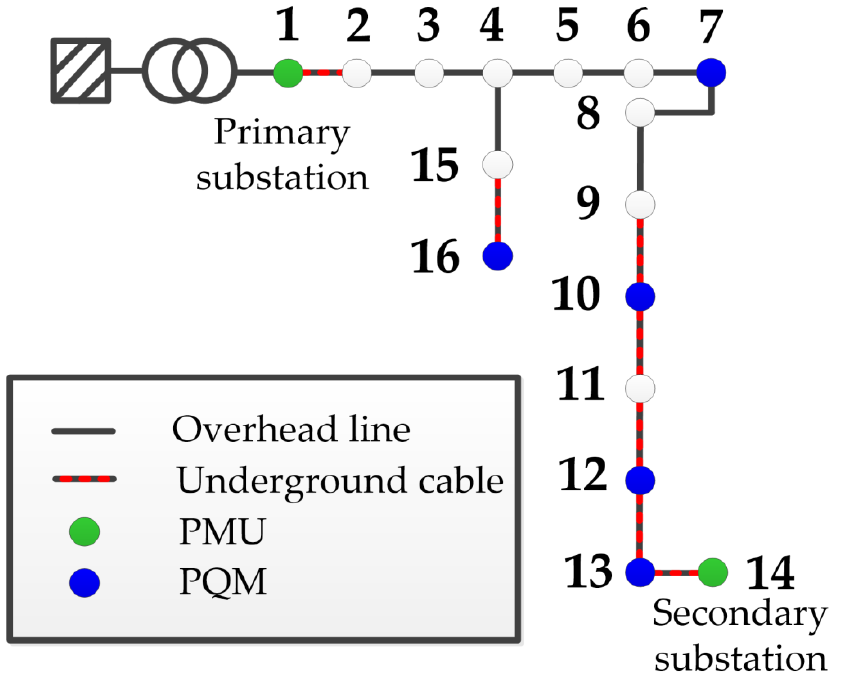
Figure 4. Single-line diagram of a 16-bus distribution feeder located in Spain with the locations of measuring devices.